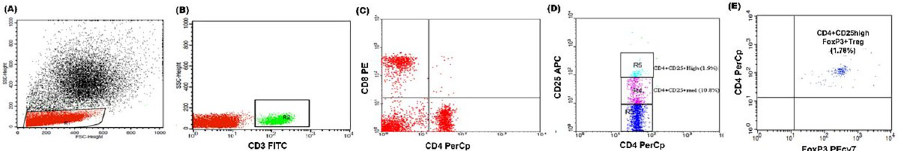
Fig 2. Flow cytometric detection of T- lymphocytes and regulatory T cells. A: Forward and side scatter plot was used to define the lymphocyte population (R1). B and C: The expression of and CD3 (R1), CD4 + , and CD8 + was assessed in lymphocytes population. D: CD4 + T cells were gated and the expression of CD25 in CD4 + T cells was detected, compared with the negative isotype control (not shown) and different gates were used to define CD4 + CD25